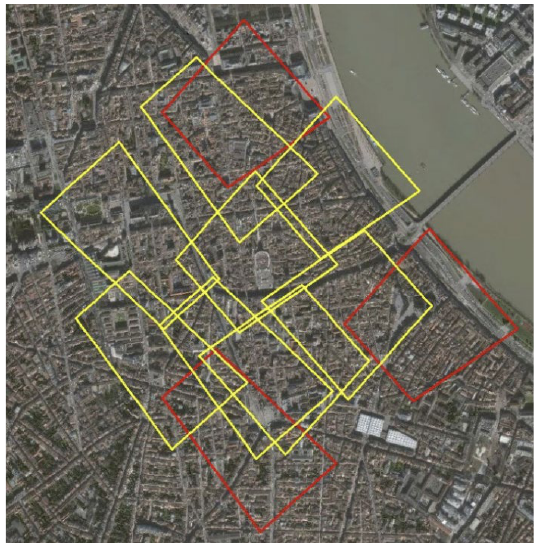
Figure 1 . Bordeaux data set. The footprints of oblique images used for training (outline in yellow) and test (outline in red) of the neural